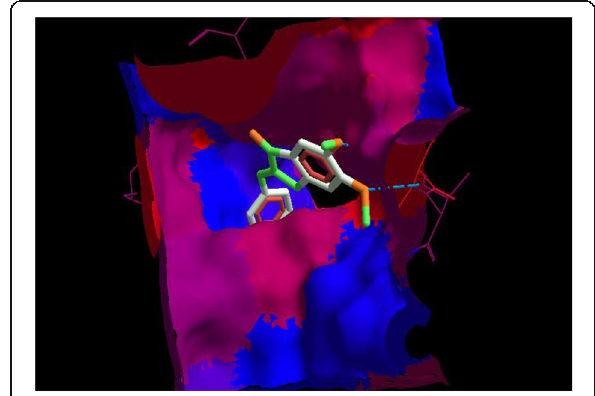
Fig. 5 Donepezil in the active site of AChE with hydrogen bonding